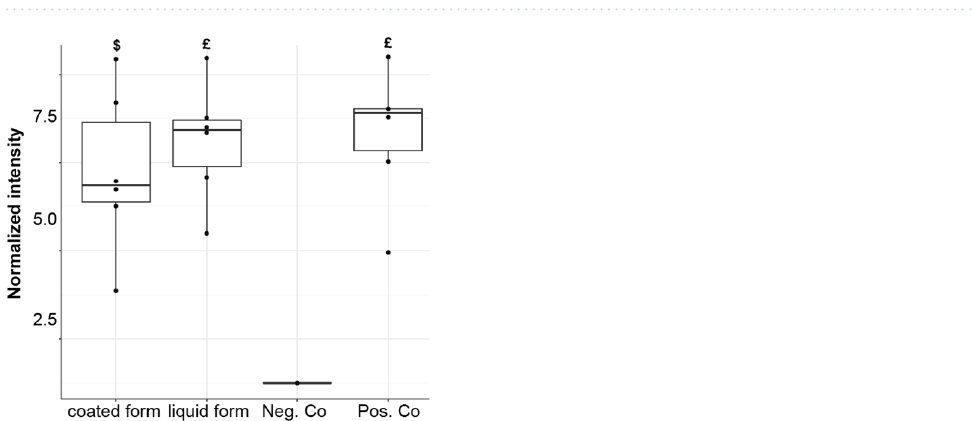
Figure 4. Fluorescence intensity after incubating InViS with NPs. NP suspensions were incubated for 2 and 24 h with InViS solution and suspensions were then centrifuged to remove NPs before fluorescence measurements. Negative control is InViS in PBS (0.4% v/v) and positive control is InViS in PBS (0.4% v/v) and OEG (1.25 mg mL −1 ). Results represent the mean and corresponding standard deviations from at least three independent experiments with two technical replicates per experiment. *p < 0.05, $ p < 0.01, £ p < 0.001 and # p < 0.0001 compared to negative control.